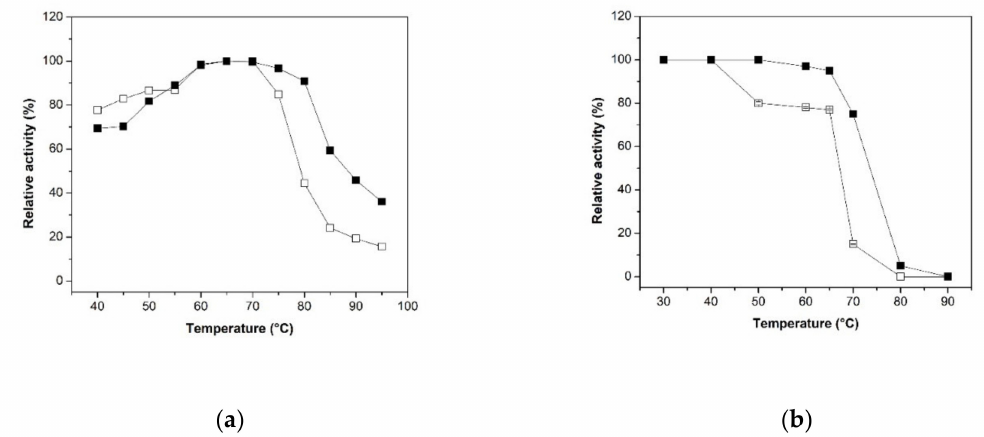
Figure 4. Effect of temperature on the β -xylosidase activity and stability of the free XynB2 Y509E and immobilized XynB2 Y509E - CLEAs. ( a ) Effect of temperature on the activity of the free XynB2 Y509E ( (cid:3) ) and immobilized XynB2 Y509E -CLEAs ( (cid:4) ) when the reactions were performed in the citrate phosphate-glycine (CFG) buffer (0.1 M, pH 6.5) using the chromogenic assay described in the experimental section. Relative activity was referred to the highest activity of the enzyme. ( b ) Effect of temperature on enzyme stability of the free XynB2 Y509E ( (cid:3) ) and immobilized XynB2 Y509E -CLEAs ( (cid:4) ) when the reactions were performed at 50 ◦ C after the enzymes were incubated for 1 h at indicated temperature. Relative activity was referred to the initial activity of the enzyme, prior to any incubation using the standard activity